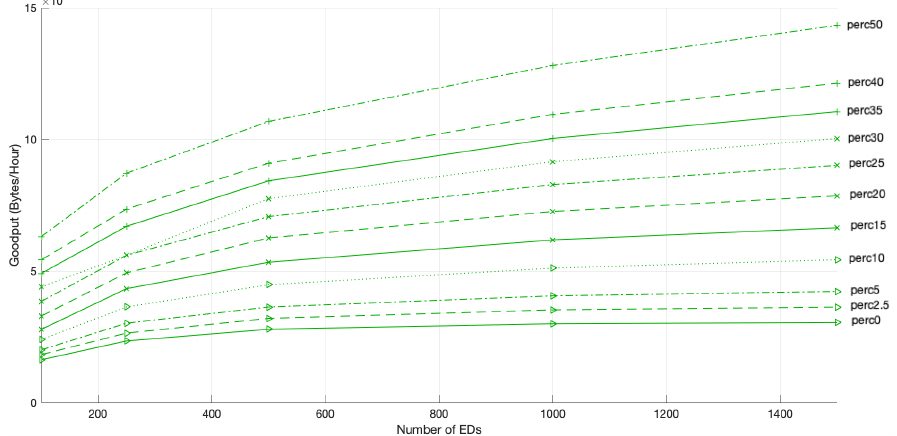
Figure 17. Network goodput for 5 GWs, different network sizes and different